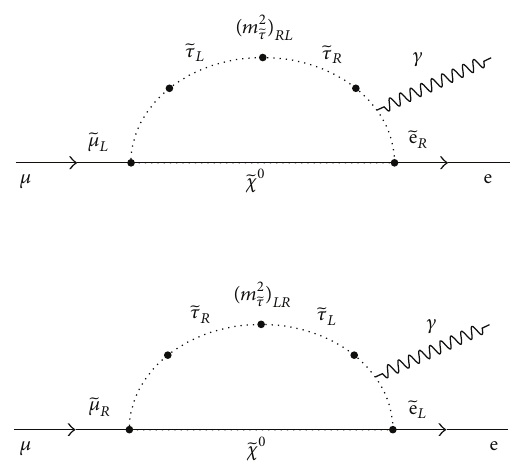
Figure 3: Loop diagrams which induce the 𝜇 → e 𝛾 reaction in SUSY-GUT SO(10) model. (𝑚 2 ̃𝜏 ) 𝑅𝐿 and (𝑚 2 ̃𝜏 ) 𝐿𝑅 are proportional to 𝑚 2 𝜏 [79].